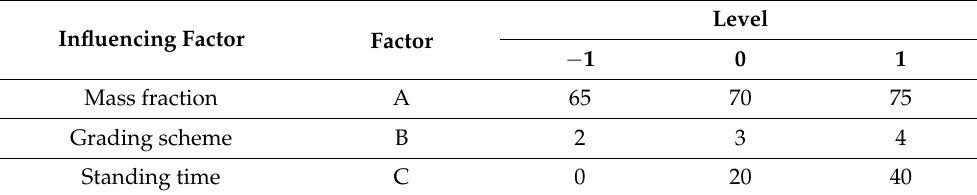
Table 7. Factors and levels of response surface